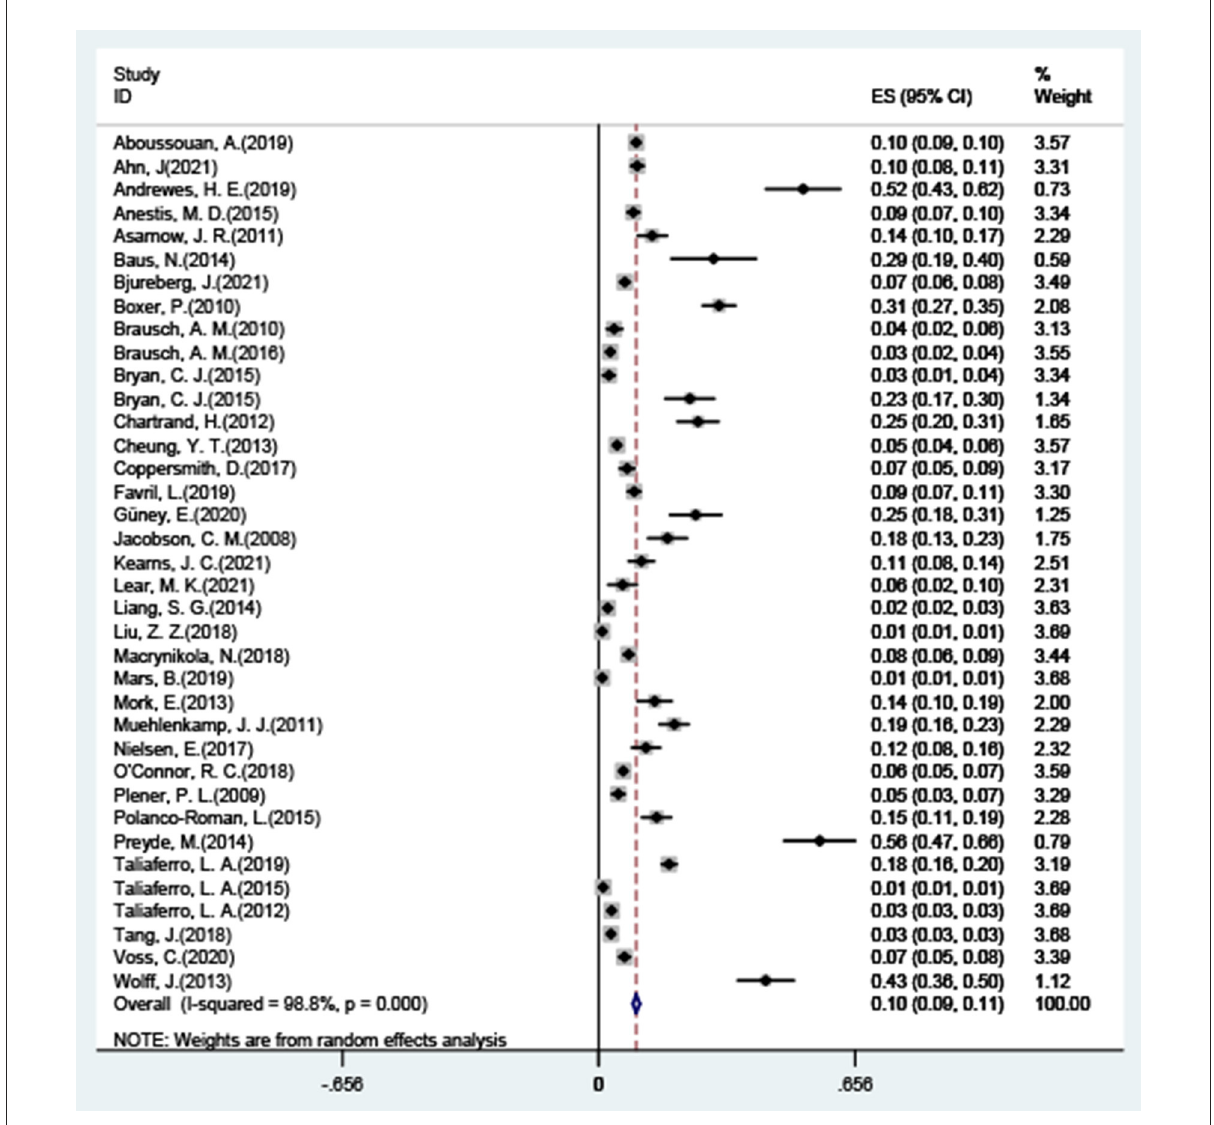
FIGURE2 Co-occurrence of NSSI +